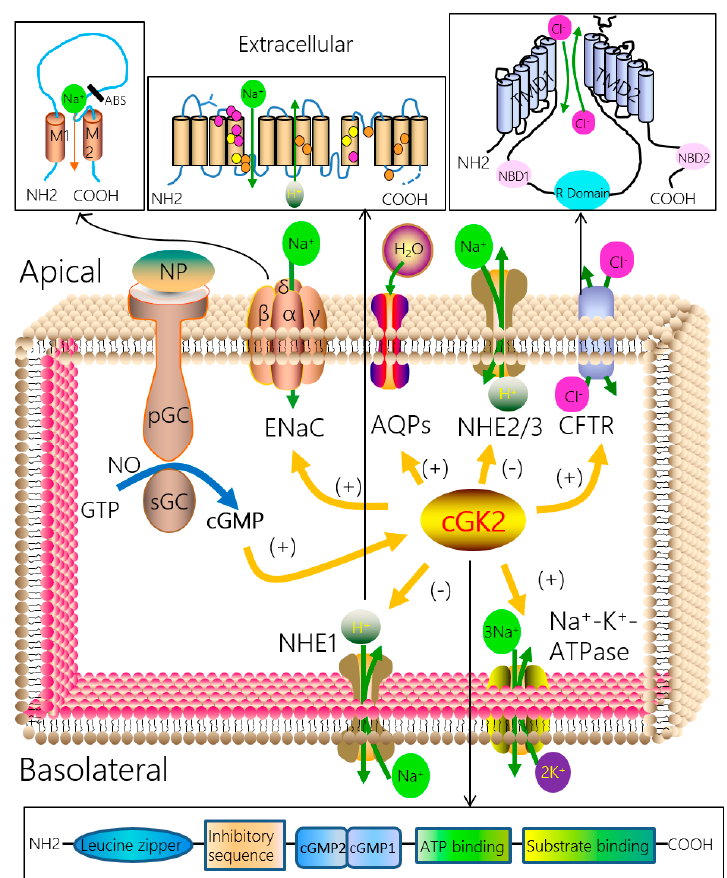
Figure 1. Regulation of fluid and salt transport by the cGK2 signal pathway in epithelial cells.